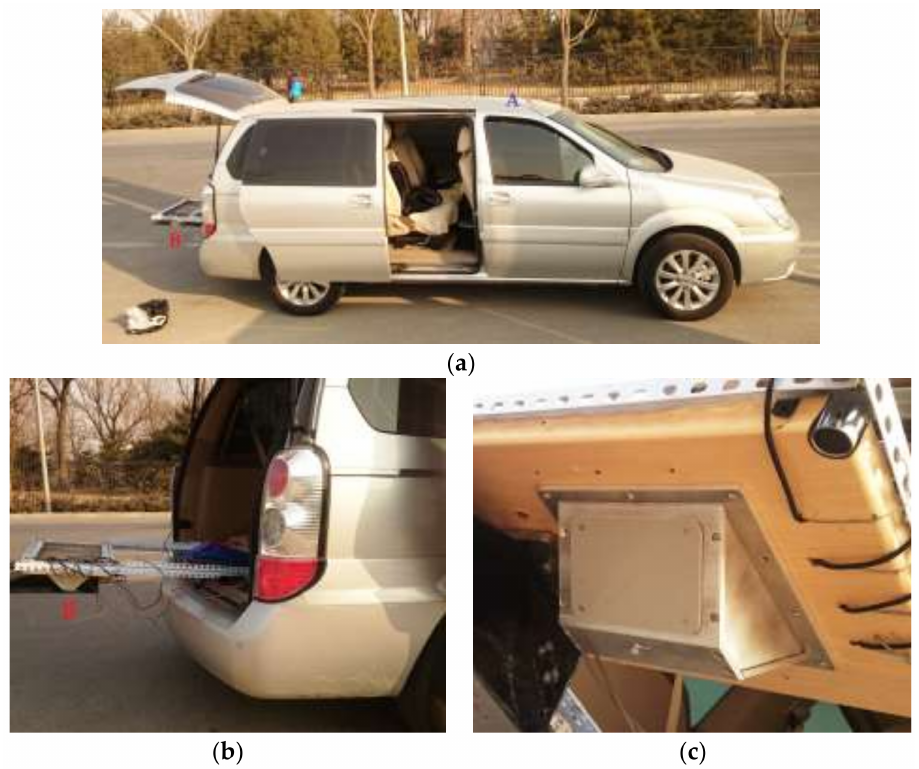
Figure 13. Field experiment. ( a ) Setup overview; ( b ) installation and fixation; ( c ) close-up of the principle